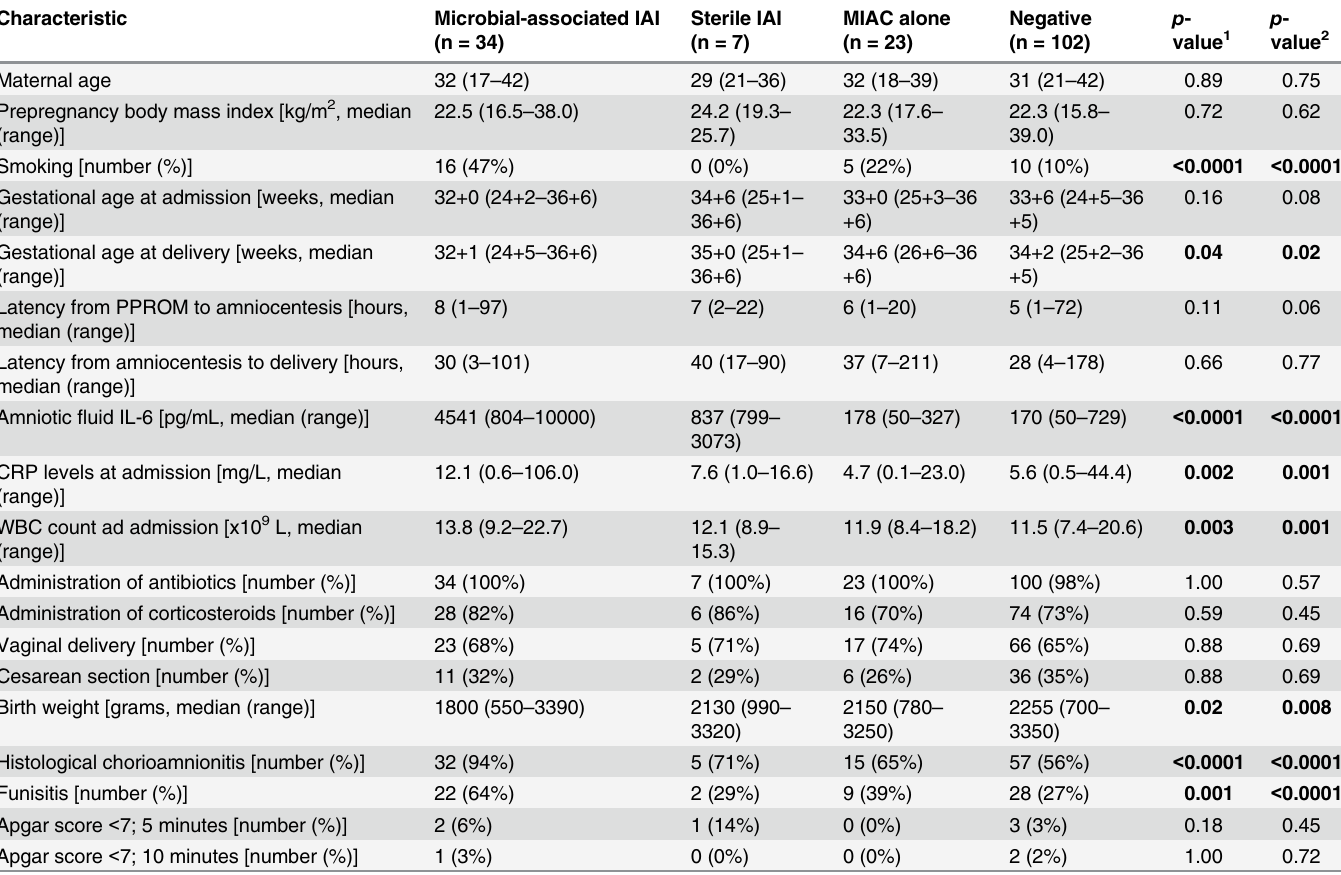
Table 1. Maternal and neonatal characteristics of preterm prelabor rupture of membrane pregnancies according to the presence or absence of microbial-associated intraamniotic inflammation, sterile intraamniotic inflammation and MIAC alone.